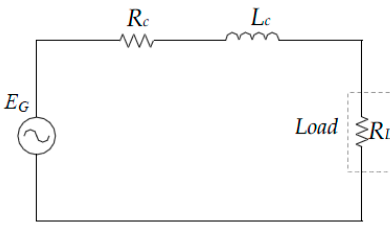
Figure 5. General electrical equivalent circuit.